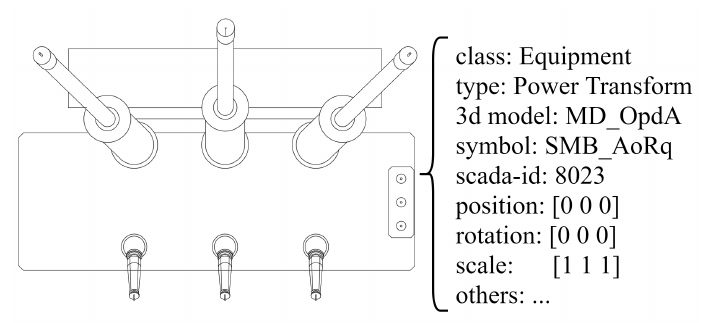
Figure 4. Example of a 3D model symbol with attributes.